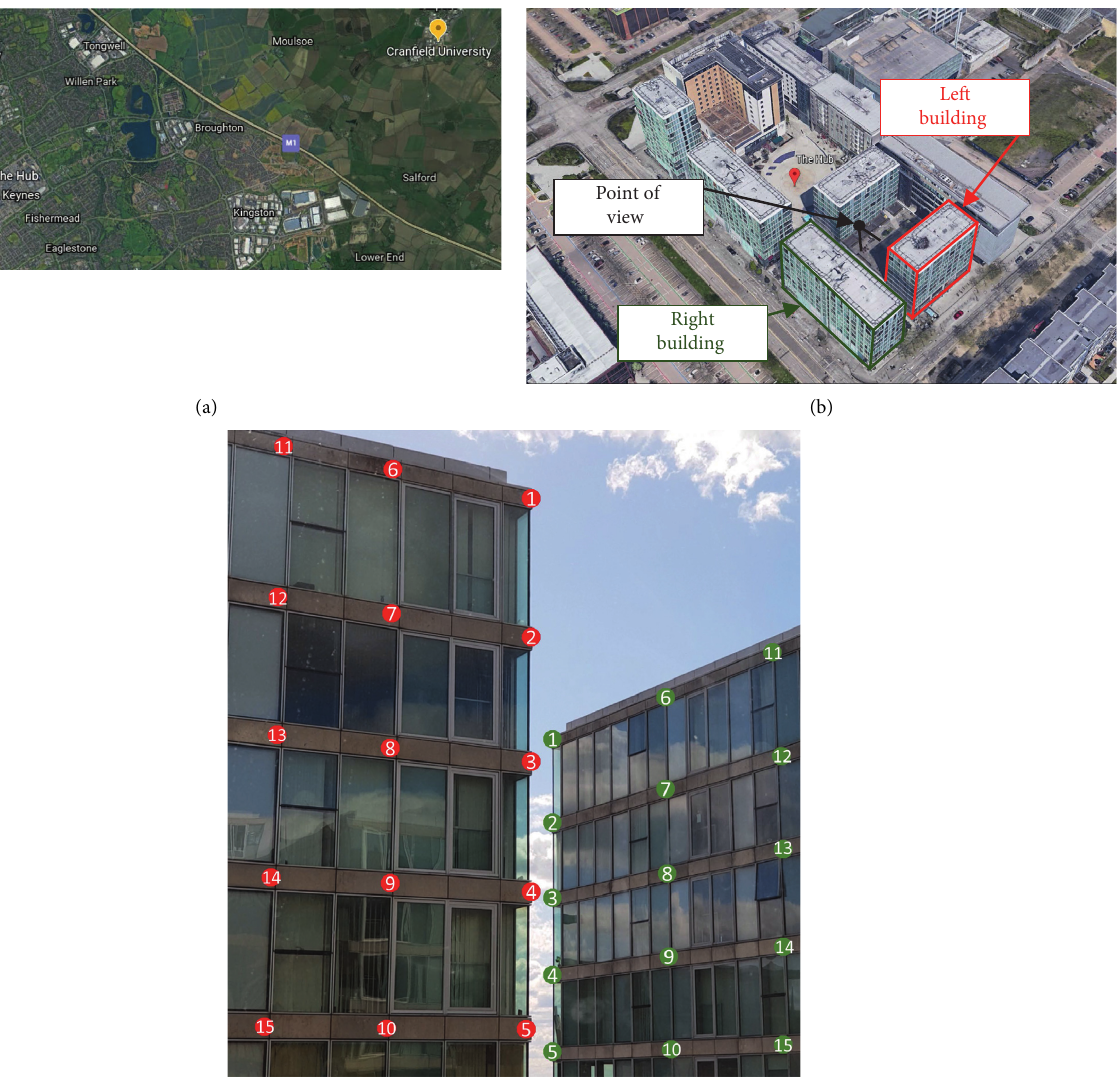
Figure 11: (a) Location of the in situ survey. (b) Satellite view of the surveyed area. (c) The first frame of the recorded video, with the position of the 30 virtual sensors